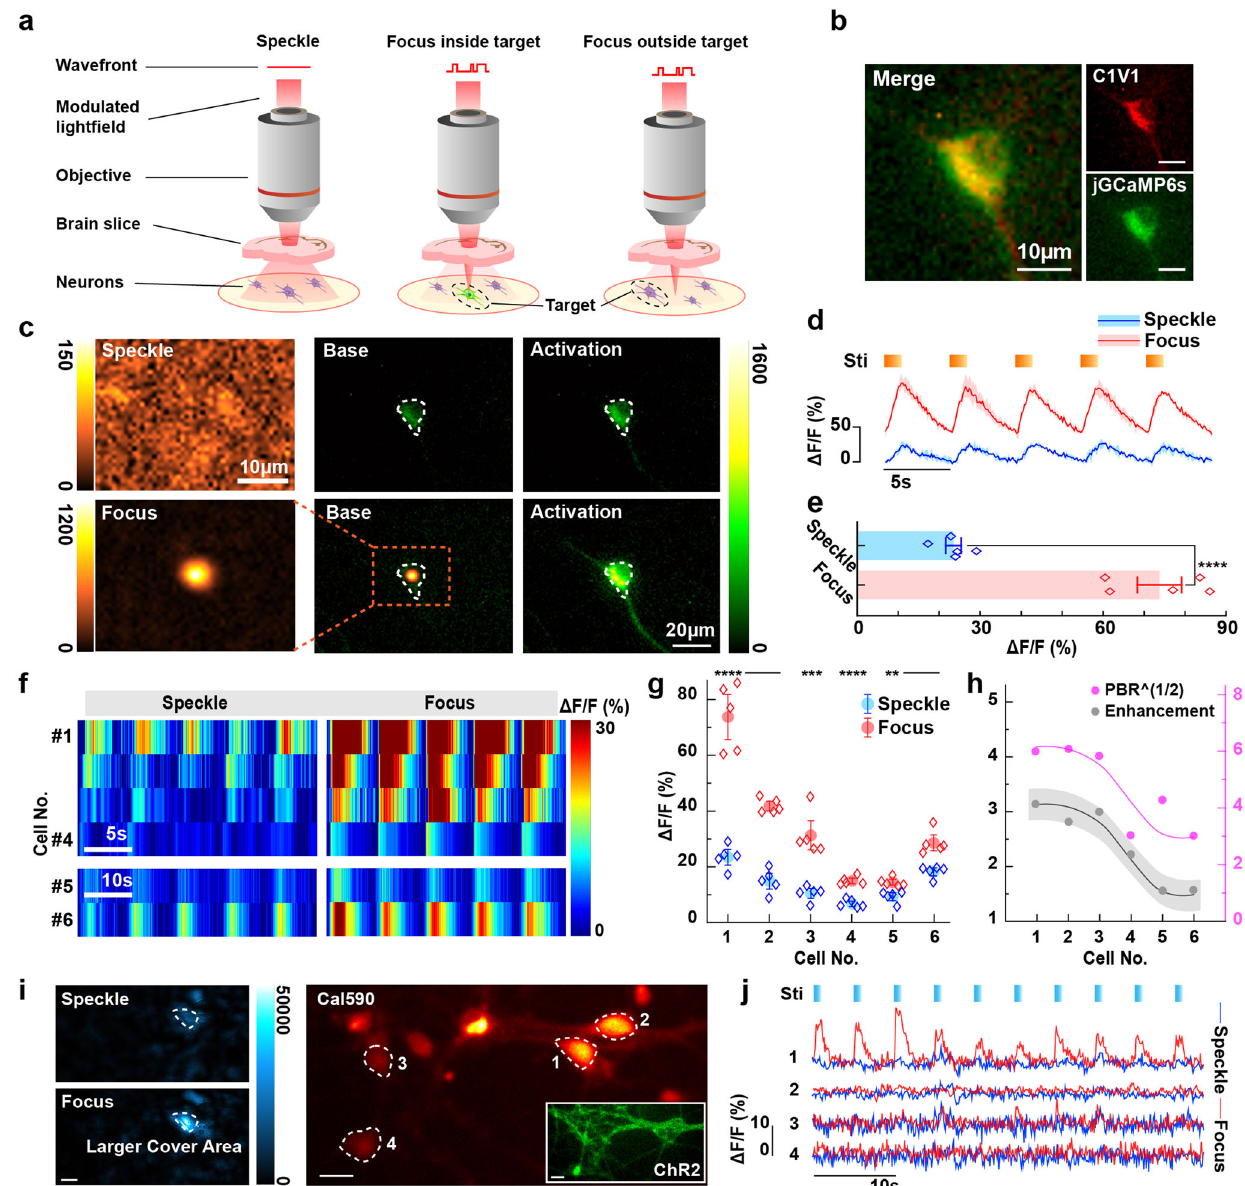
Fig. 4 The manipulation of fCOAT system on neural activities. a Diagram illustrating the experimental scheme used to demonstrate the ability of fCOAT focusing to elicit stronger calcium signals through 200- μ m-thick mouse brain tissue. The black dashed line indicates the positional relationship between the target neuron and the focus. b The merge images of the expression of photosensitive protein and calcium indicator of the target neuron. Scale bar, 10 μ m. c Targeted activation of calcium signaling in a representative neuron after focusing through the brain slice. Green: jGCaMP6s fl uorescence signals. Orange: excitation beam intensity through the brain slice with and without wavefront shaping. The white dotted line: the location of the optimized focus and the boundaries of individual neuron. d Quantitative analysis of jGCaMP6s fl uorescence signals obtained from the neuron in c . Shadows are given by the upper and lower limits of stimulations. e The histogram representation from the data in d . Comparison of peak neural response (mean ± SE) to different types of stimuli, **** P < 0.0001, strong (73.76 ± 5.41% Δ F ⁄ F) versus weak (23.47 ± 1.89% Δ F ⁄ F). f Individual traces of jGCaMP6s fl uorescence in different C1V1 neurons under 589 nm illumination using focus and speckle light fi elds. g The statistical results of neuron data in f and the corresponding analysis between different types of stimuli. Error bars:1.5 SE of fi ve measurements of peak neural responses. h The results of the relationship between the focus PBR and the calcium signals enhancements. The shadow is formed by moving the trend line up and down. i Targeted activation of calcium signaling in representative neurons after focusing through the brain slices. Red: Cal590 fl uorescence signals. Green: the expression of the used opsin ChR2. Blue: excitation beam intensity through the brain slice with or without wavefront shaping. The white dotted line: the boundaries of individual neurons. Scale bar, 20 μ m. j Individual traces of Cal590 fl uorescence in different ChR2 neurons under 488 nm illumination using extended focus and speckle light fi elds. (Supplementary Fig. 5c). We ruled out the possibility of multi- surrounding neurons (#19, #20, #21) as examples, neuron #19 point stimulations and considered that the two different does not express ChR2, while the other two both expressed, and stimulation modes can be regarded as a single in fl uencing factor our stimulation target neuron is #21. With speckle stimulation, for this neural population. Taken the stimulation target and the neither #19 nor #20 produce effective follower responses at the COMMUNICATIONS BIOLOGY| (2023) 6:128